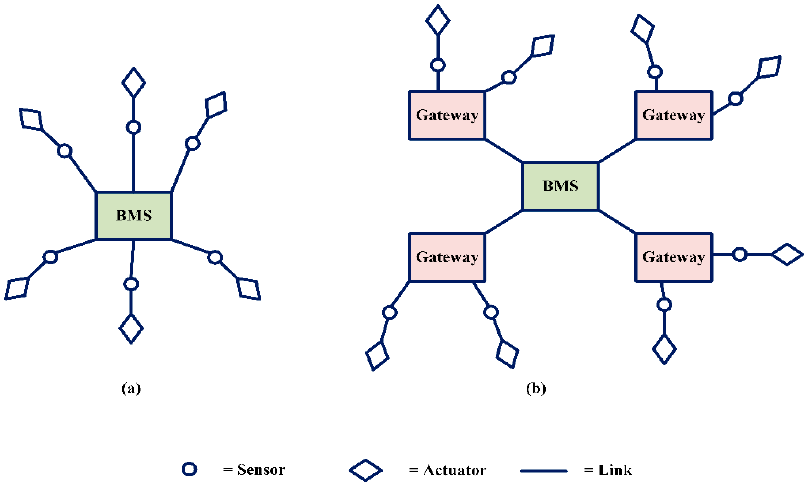
Figure 2. BMS implementation topology: ( a ) centralized, ( b ) distributed.